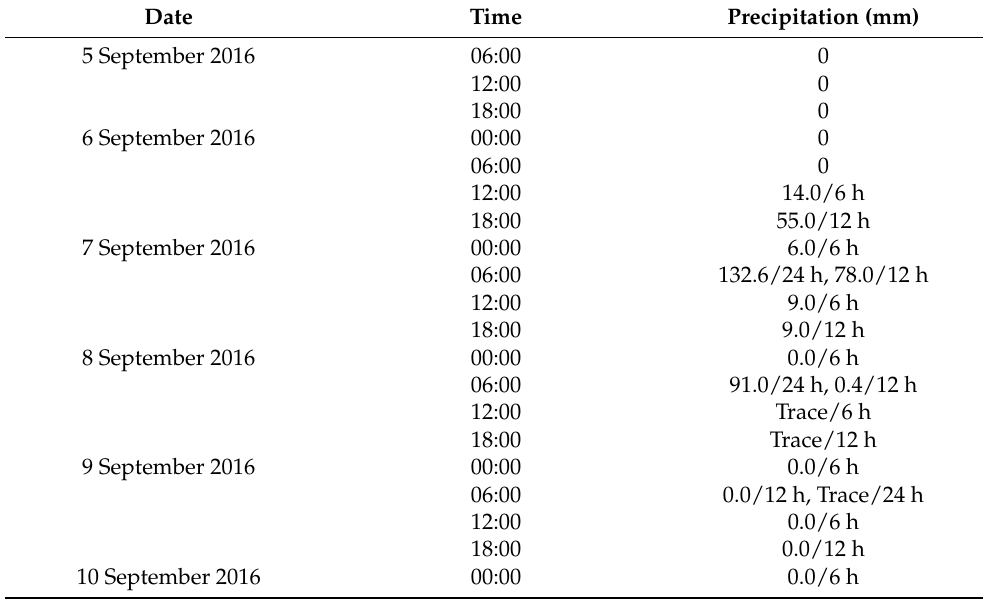
Table 1. Development of the flood event that took place between 6 and 8 September 2016, in Messenia regional unit (Hellenic National Meteorological Service-HNMS, Kalamata station, WMO-ID: